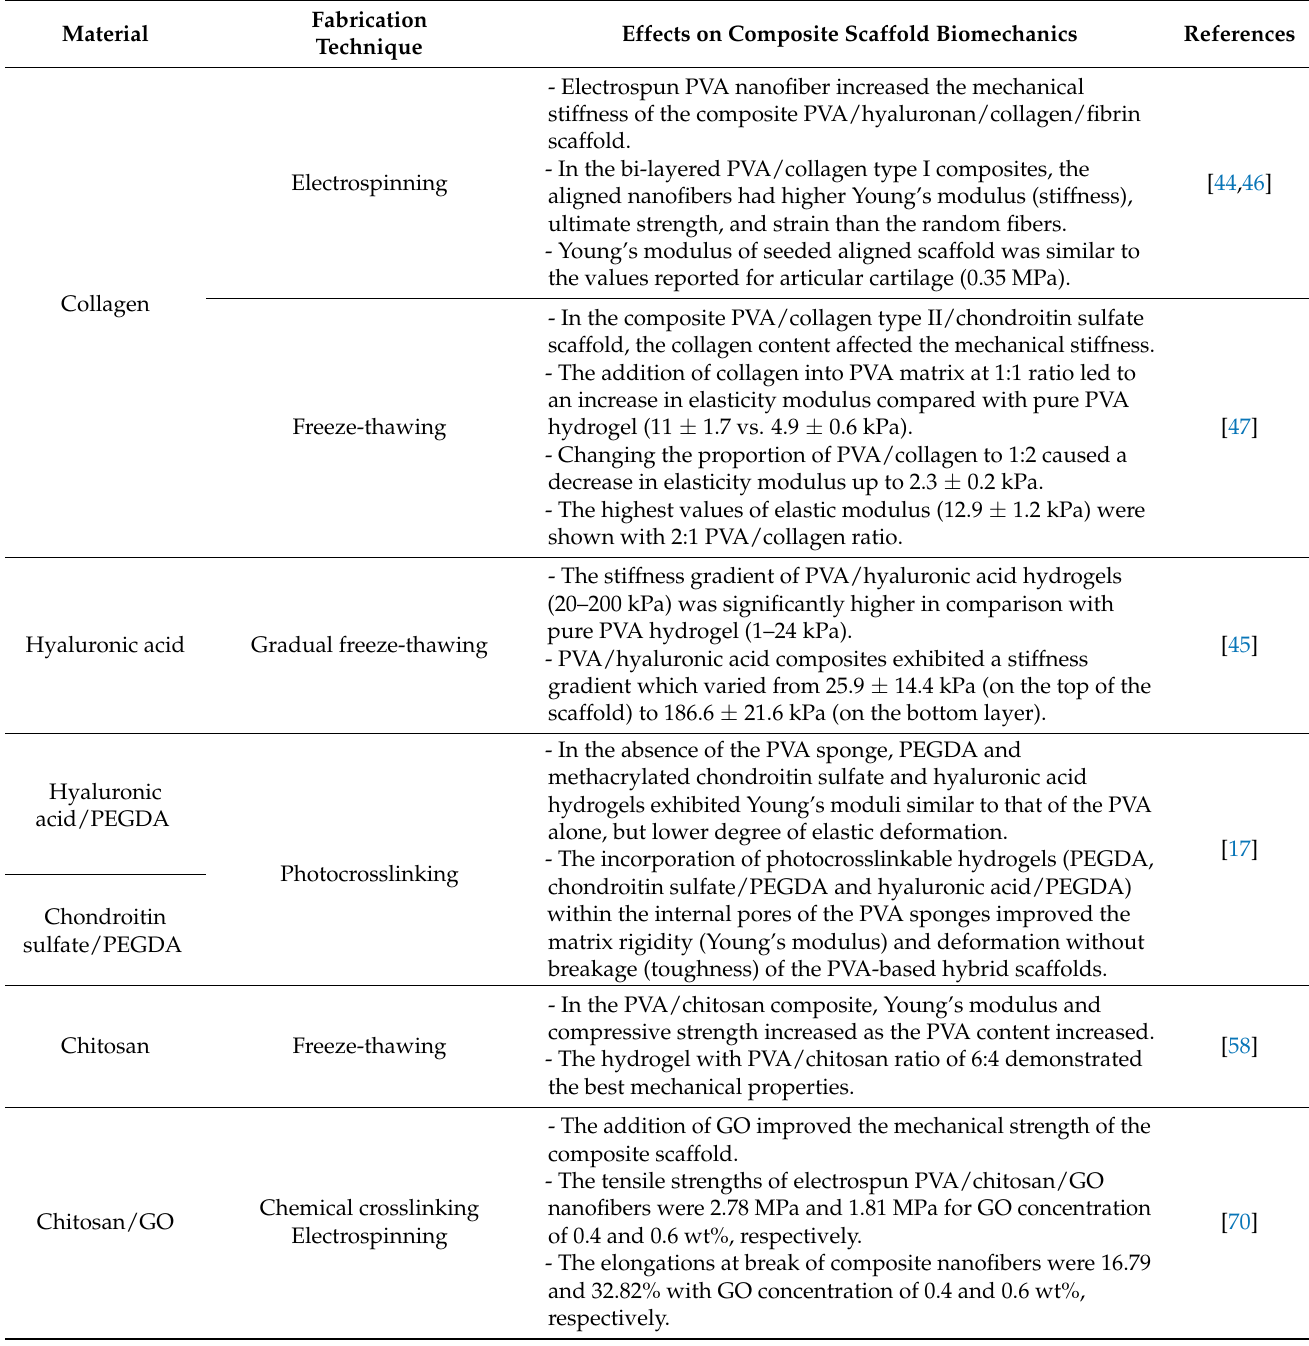
Table 4. Main effects of natural/synthetic additives and fabrication techniques on the mechanical properties of the composite